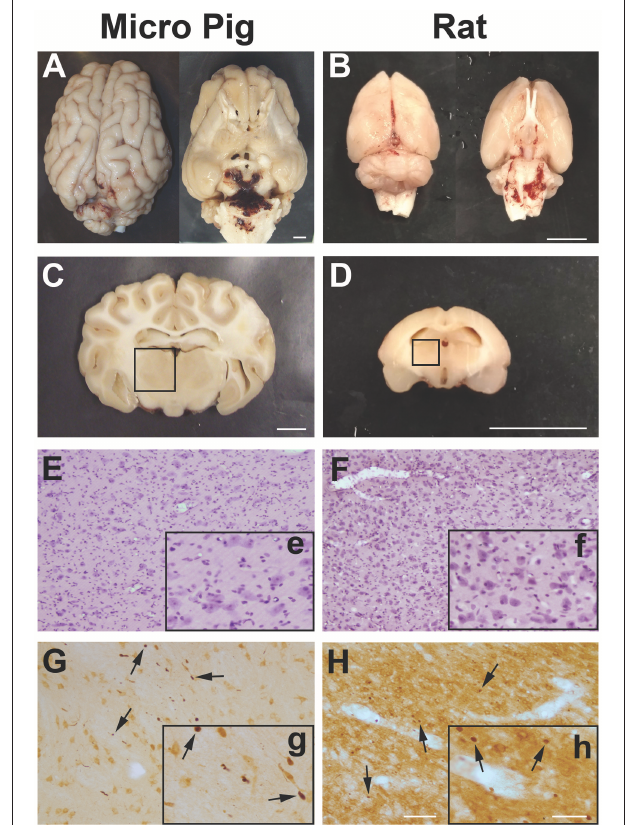
FIGURE 1 | Central fluid percussion injury does not result in focal brain damage, but does precipitate diffuse axonal injury in the thalamus of both rats and micro pigs 1 day following injury. Representative photographs of the gross (A,C) micro pig and (B,D) rat brain 1 day following cFPI. The top panels are dorsal and ventral views of the entire brain 1 day post-injury while panels (C) and (D) represent 5mm thick coronal sections at the level of the rostral thalamus in the (C) micro pig and (D) rat. The boxes indicate the regions of analysis of microglia process convergence in the thalamus of both species. Diffuse cFPI also did not result in cell damage/death. Hematoxylin and eosin staining reveled no square wave cellular damage in the thalamus of either the (E) micro pig or (F) rat thalamus at 1 day following cFPI. Amyloid precursor protein (APP) immunohistochemistry in the (G) micro pig and (H) rat